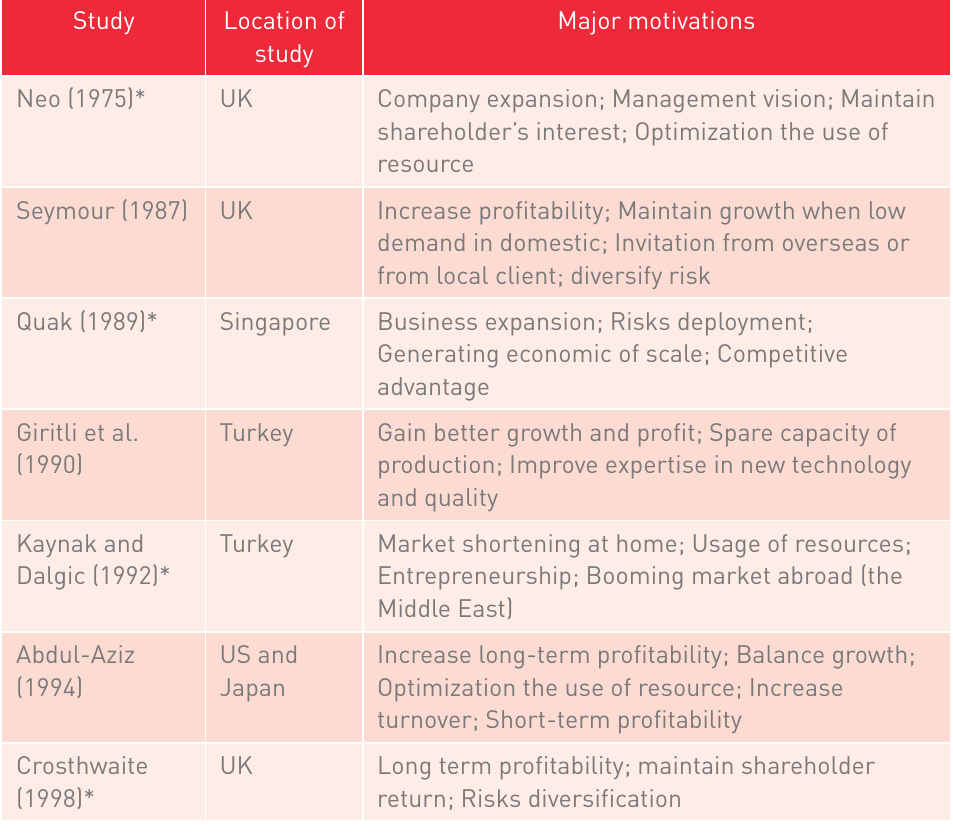
Studies on motivation for seeking overseas projects Study Location